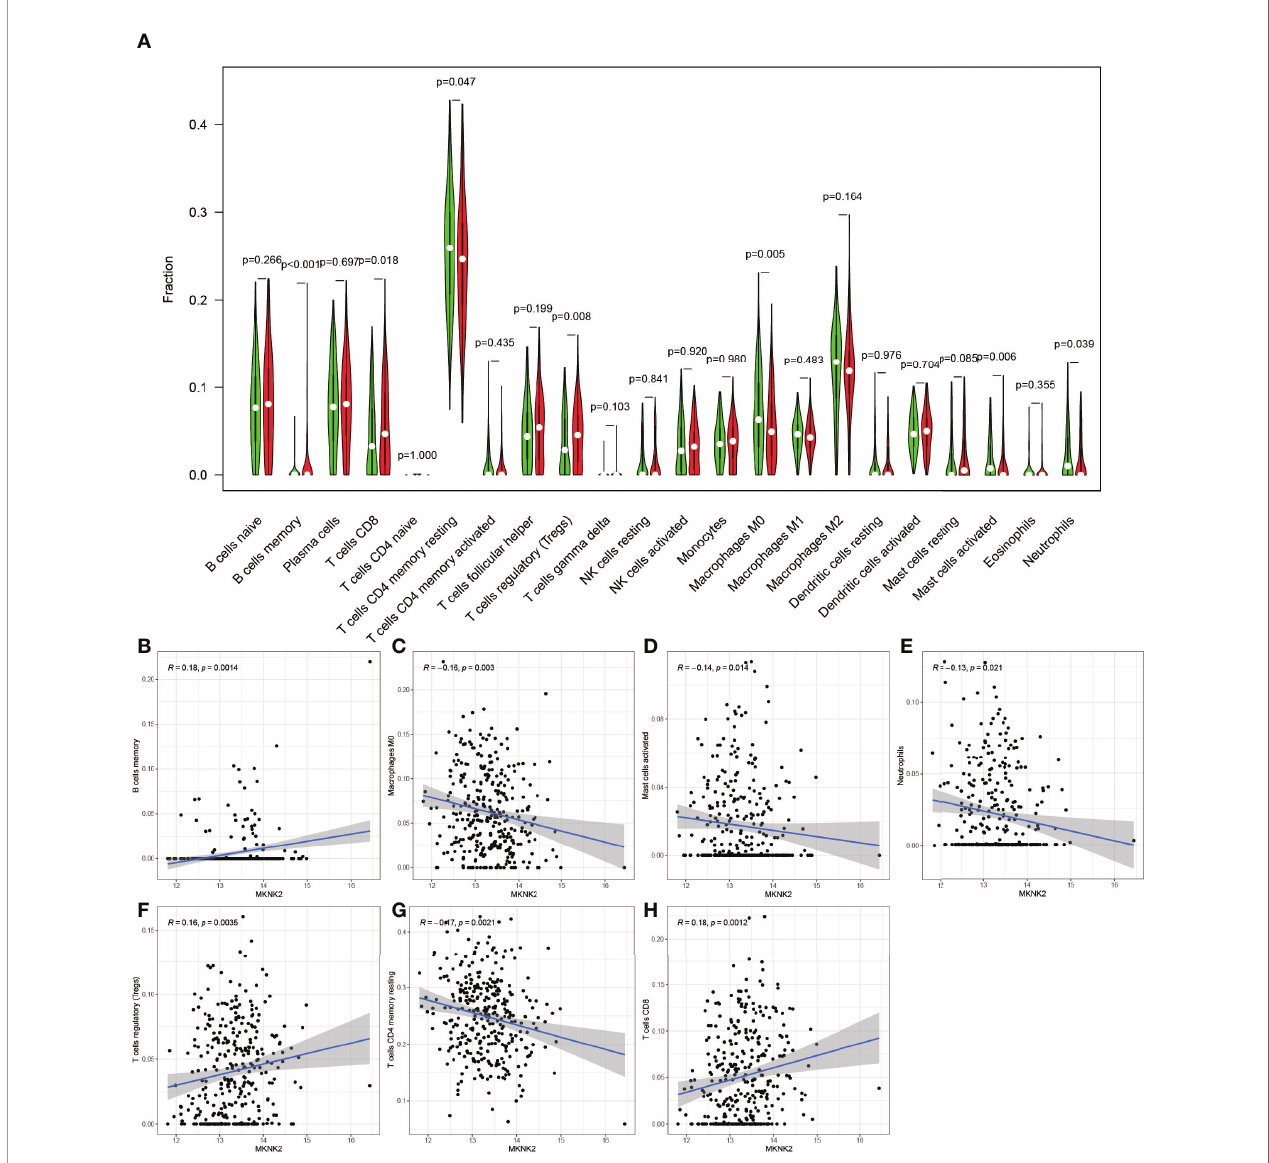
FIGURE 13 | MKNK2-based immune cell analysis. The (A) graph shows that there are 7 immune cells associated with MKNK2 in gastric cancer (P-value < 0.05). The graphs (B, F, H) indicate that these three immune cells are positively correlated with MKNK2. (C – E, G) indicate that these four immune cells are negatively correlated with